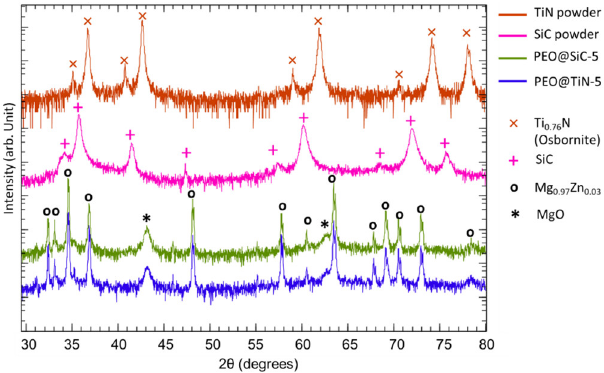
Figure 2. XRD spectra of the ceramic powders used for NP synthesis and PEO coatings.